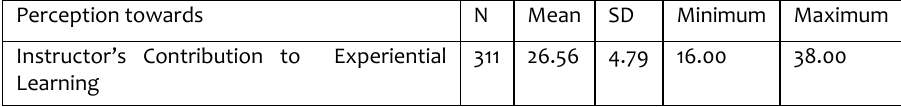
Table 1: Descriptive Statistics of the Trainees’ Perception Scores on the Instructors’ Contribution to the Trainees’ Experiential Learning (N= 311) Perception